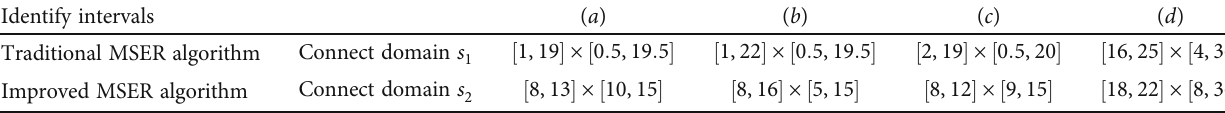
Table 1: Improved front-to-back connected domain intervals.